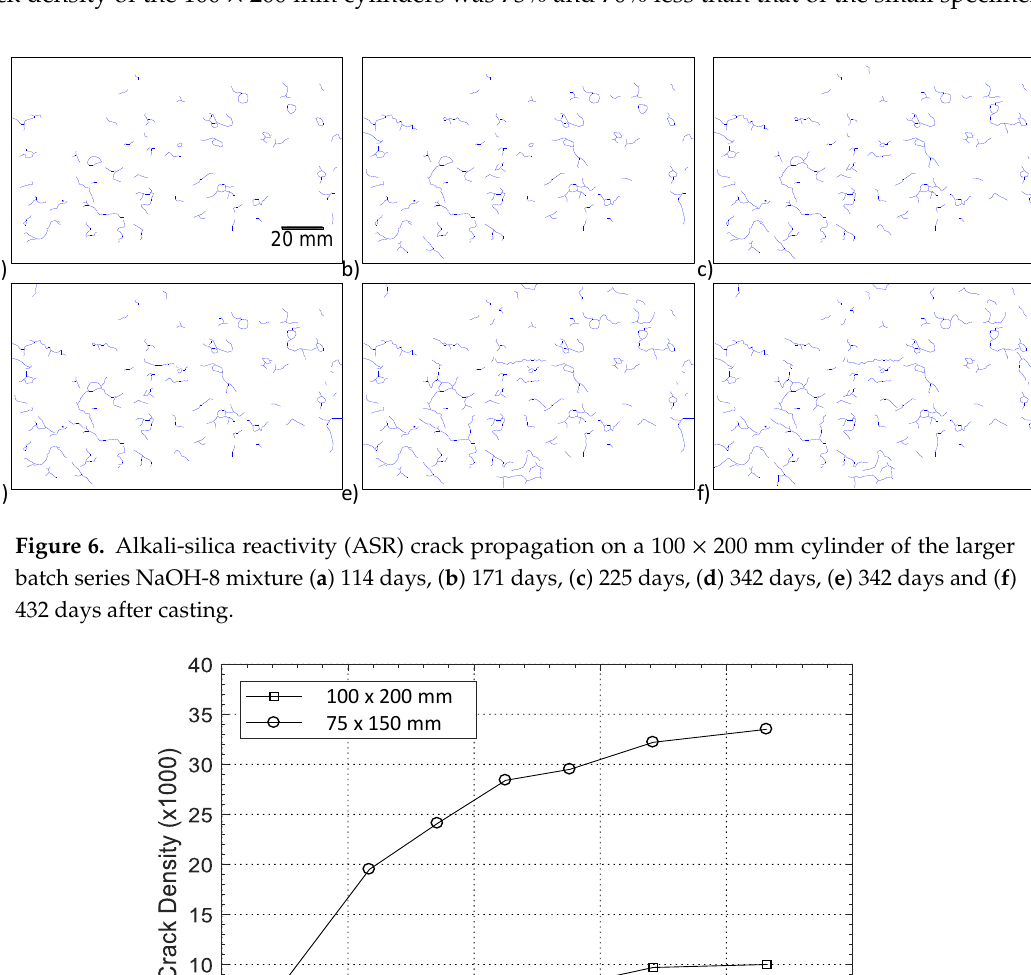
Figure 5. Alkali-silica reactivity (ASR) crack propagation on a 75 × 150 mm cylinder of the larger batch series NaOH-8 mixture ( a ) 114 days, ( b ) 171 days, ( c ) 225 days, ( d ) 342 days, ( e ) 342 days and ( f ) 432 days after casting.